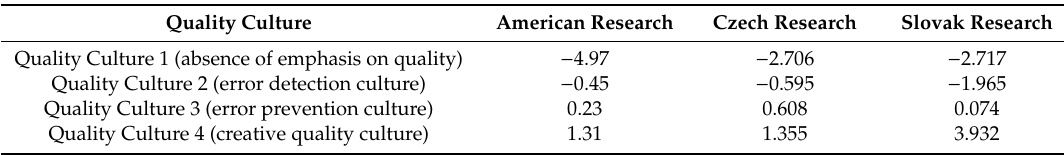
Table 20. Comparison of